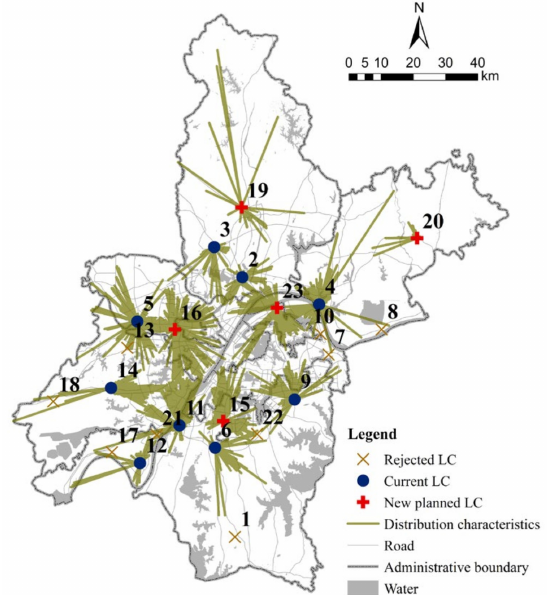
Figure 10. Site location and allocation results by the P-median